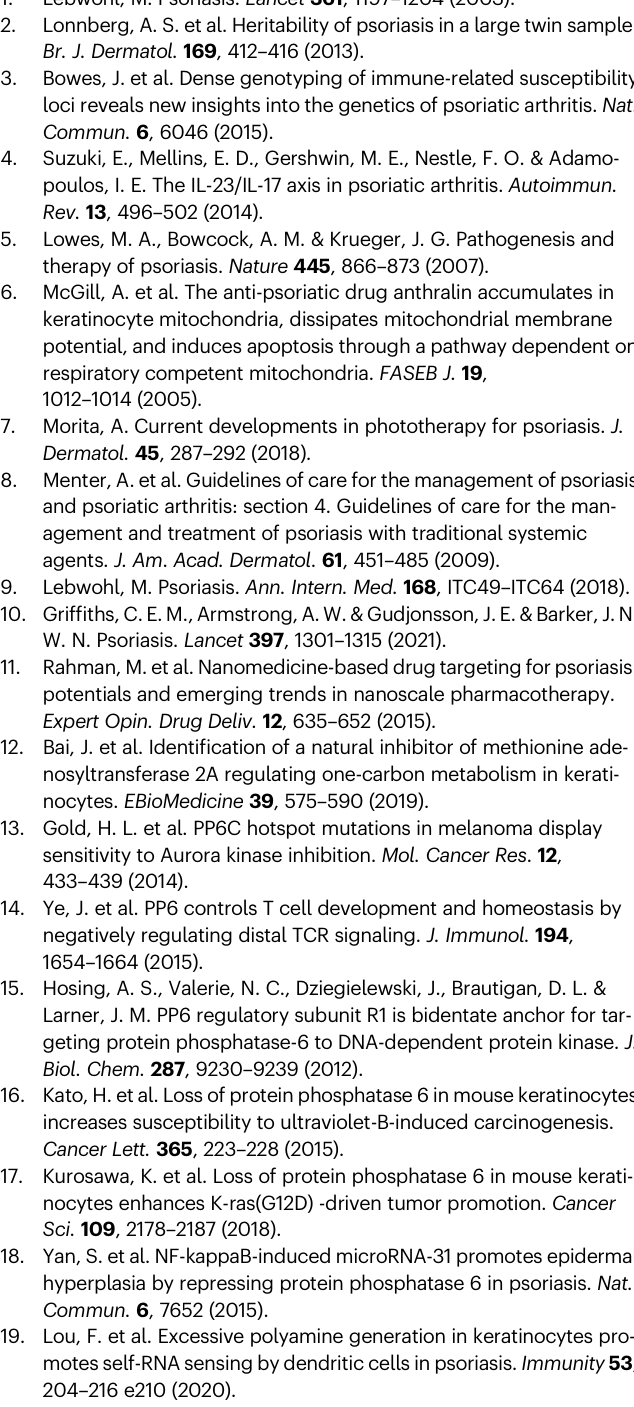
Fig. 6 | IGBP1 promotes PP6 expression in keratinocytes. a Immunoblotting of HES1, IGBP1, and PP6 expression in HaCaT cells transfected with or without HES1 siRNA (si-HES1) and IGBP1 overexpression plasmid (IGBP1). b quantitation of PP6expressioninHaCaTcellstransfectedwithorwithoutHES1siRNA(si-HES1)and IGBP1 overexpression plasmid (IGBP1) ( n =4). c Immunoblotting of IGBP1 and PP6 expression in HaCaT cells transfected with scramble siRNA (Ctr) or with IGBP1 siRNA (si-IGBP1). d Immunoblotting of PP6-immunoprecipitated proteins in HaCaTcells transfected with anHA-Ubiquitin plasmidand scramblesiRNA(Ctr)or with IGBP1 siRNA (si-IGBP1). e Immunoblotting of IGBP1 and PP6 expression